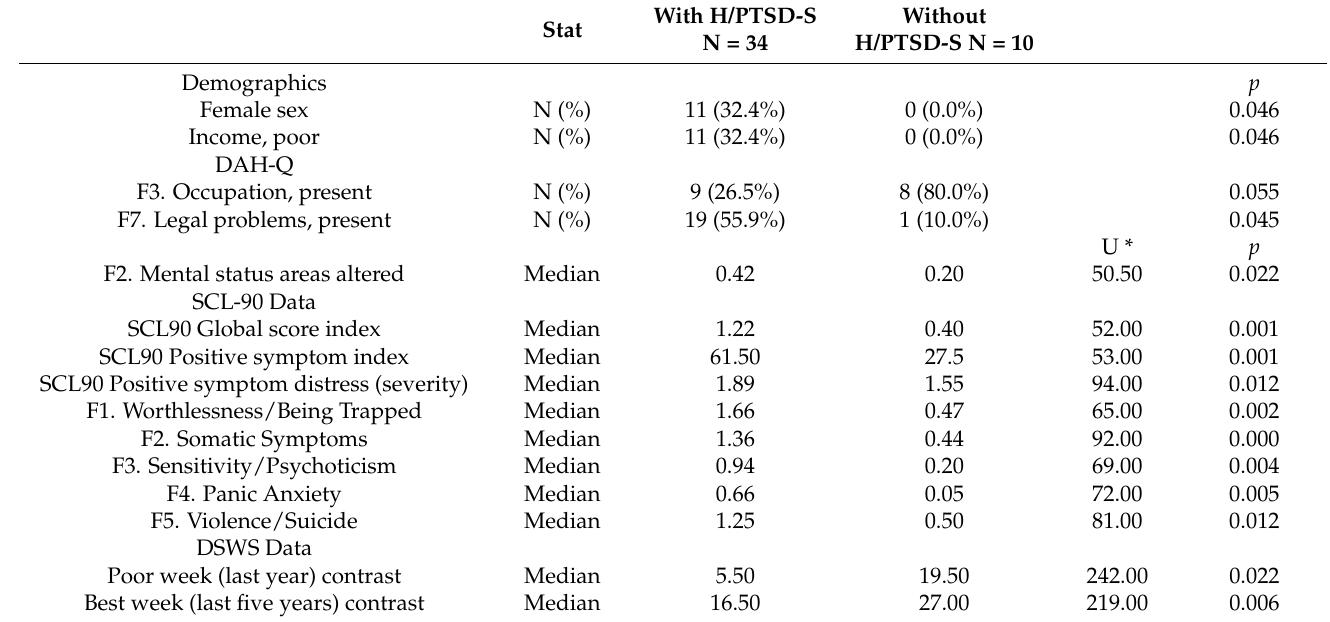
Table 2. Differences between patients with and without H/PTSD-S according to the nonparametric test. With H/PTSD-S Without Stat N = 34 H/PTSD-S N =